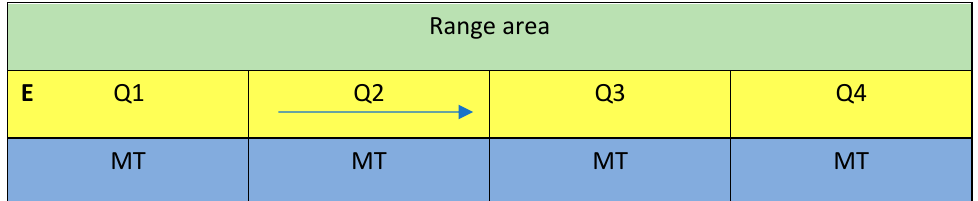
Figure 1. Overhead schematic of free-range hen sheds used in the study showing the four quarters, Q1–Q4. Q1 was always the quarter nearest to the annex, where staff would enter ( E ). The blue area is where the multi-tier (MT) structure was positioned, the yellow area was the litter, and birds could reach the range via popholes from the litter area. The arrow shows the direction that staff would walk, scattering litter from side-to-side in the relevant pelleted feed (PF) treatment/quarter.